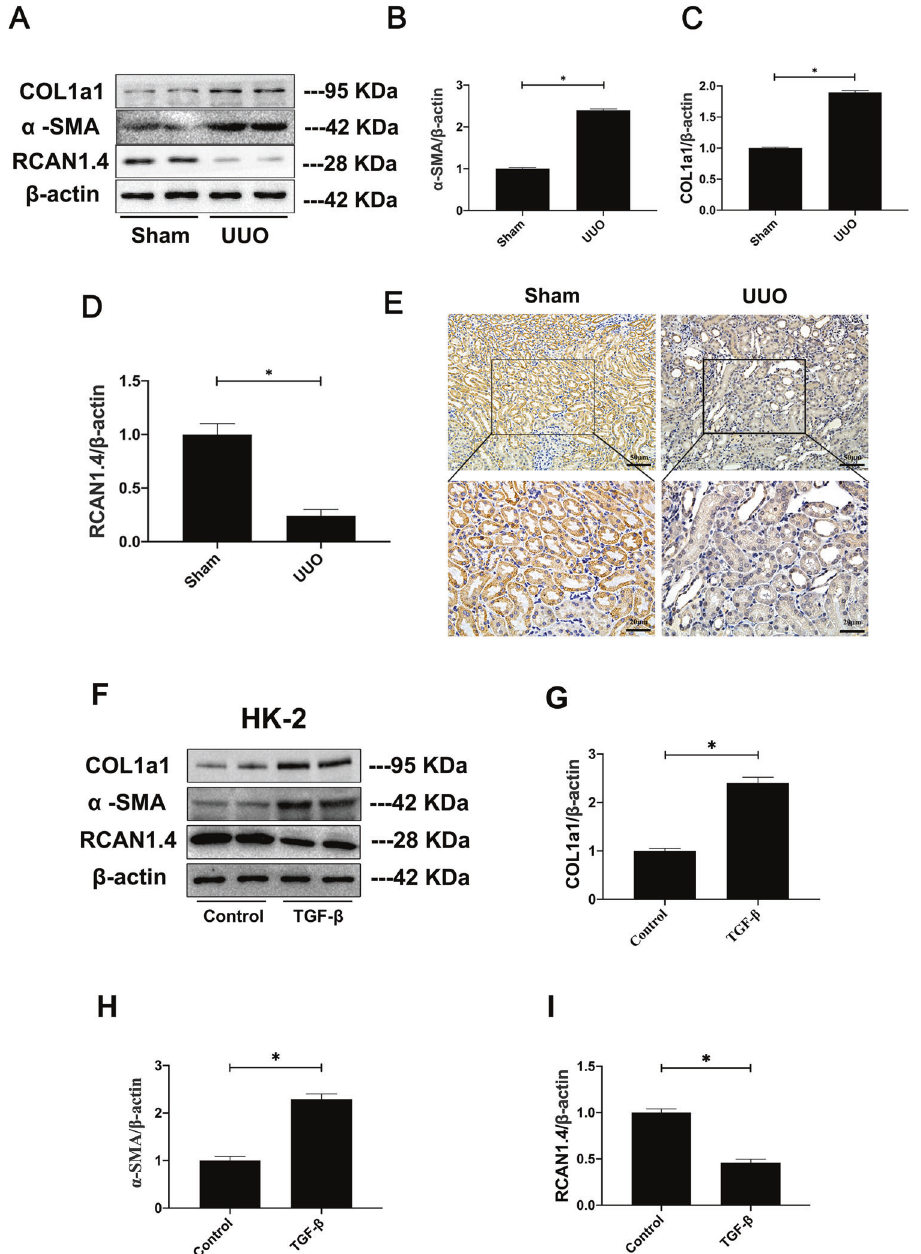
Fig. 1 RCAN1.4 expression was down-regulated in vivo and vitro. Western blotting analysis was performed after collecting kidney lysates. A , F Representative blots of RCAN1.4, COL1a1, α -SMA, and β -actin; B , H α -SMA/ β -actin ratio; C , G COL1a1/ β -actin ratio; D , I RCAN1.4/ β -actin ratio; E Immunohistochemistry signals of RCAN1(Scale bars, 20 μ m and 50 μ m). The results are expressed as the mean ± standard error of the mean (S.E.M.) for 3 – 4 independent experiments. * p < 0.05, as